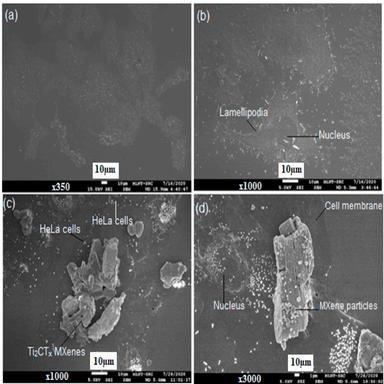
FE-SEM micrographs of HeLa cells in (a–b) control and (c–d) in 2D cell culture after exposure to 500 μg/mL of Ti2CTX MXenes, respectively.